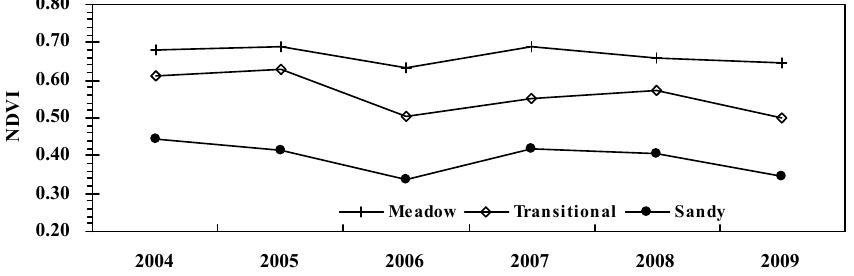
Figure 6. Plot showing mean annual values for maximum Normalized Difference Vegetation Index (NDVI) averaged across the meadowlands (Meadow), the transitional zones (Transitional), and the sandy dunes (Sandy) in the study